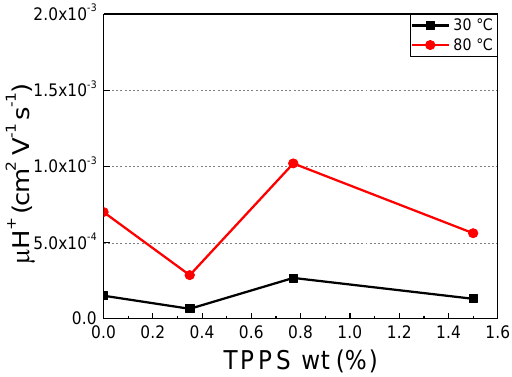
Figure 4. Proton mobility at different temperatures.